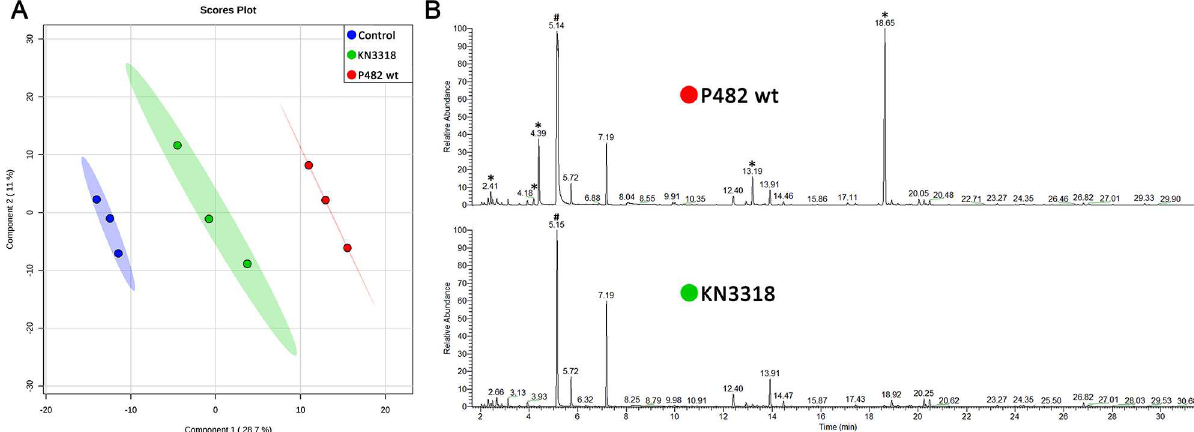
Fig 3. Data obtained from MetaboAnalyst 3.0 and GC-MS results. (A) PLS-DA plot of VOC’s produced by P . donghuensis P482 and KN3318 mutant with media as a control (triplicates); (B) TIC chromatographs from GC-MS analysisshowingdifferent peaks between P . donghuensis P482 and KN3318 mutant. Significant peaks that differ betweenwild type and mutant are indicatedby asterisk. Dimethyl disulfide(DMDS) is indicatedby “#”.